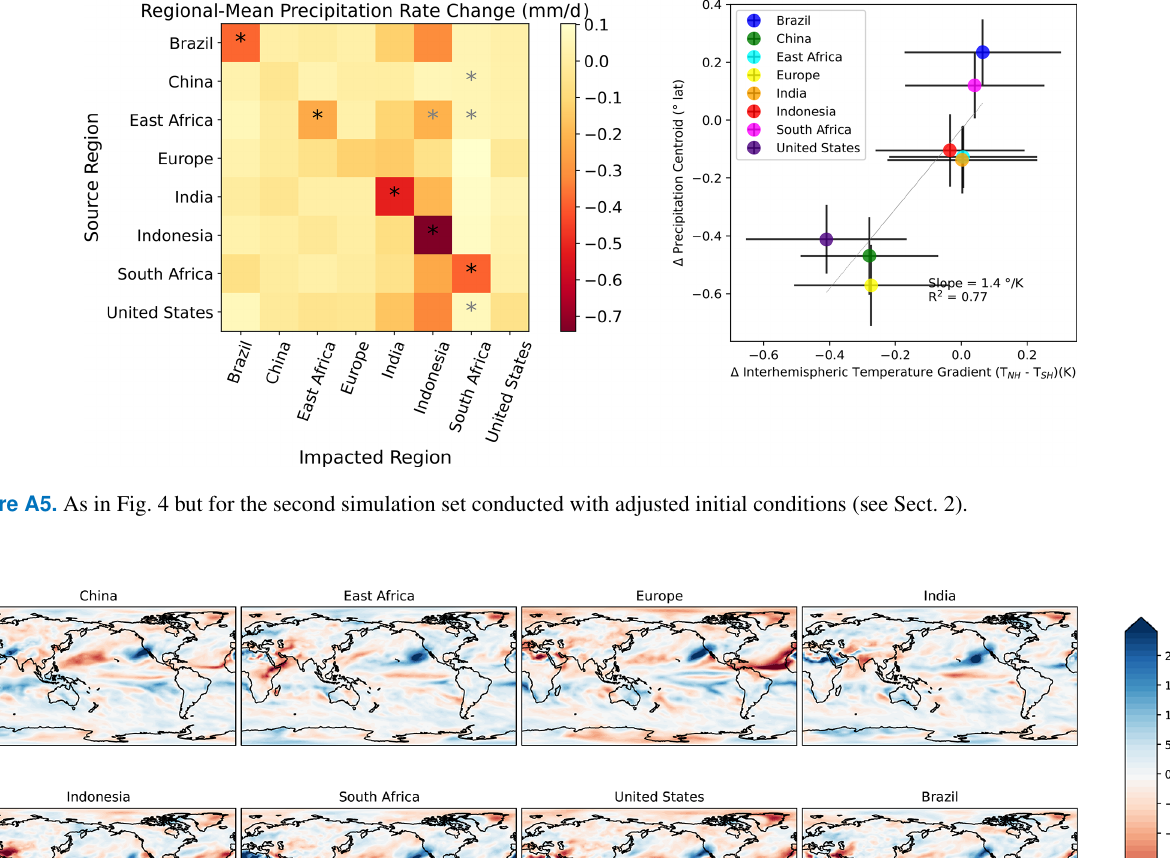
Atmos. Chem. Phys., 23, 3435–3452, 2023